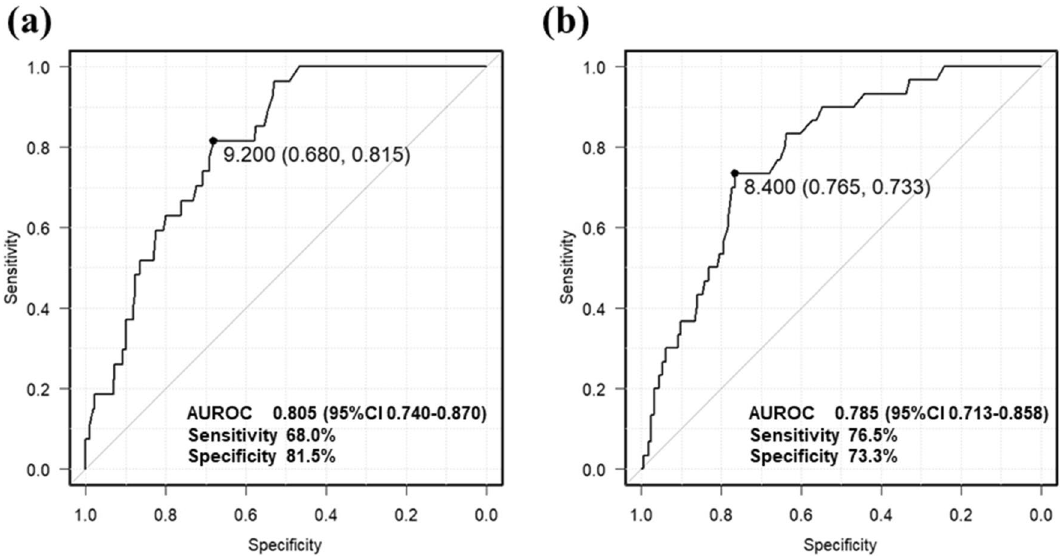
Figure 2. ROC curve analysis of LSM and prediction of HCC. The ROC curve shows LSM in predicting HCC after SVR with IFN-free treatment. ( a ) Pre-treatment LSM. ( b ) LSM at the time of SVR24. ROC, receiver operating characteristic; LSM, liver stiffness measurement; HCC, hepatocellular carcinoma; SVR24, sustained virological response at 24